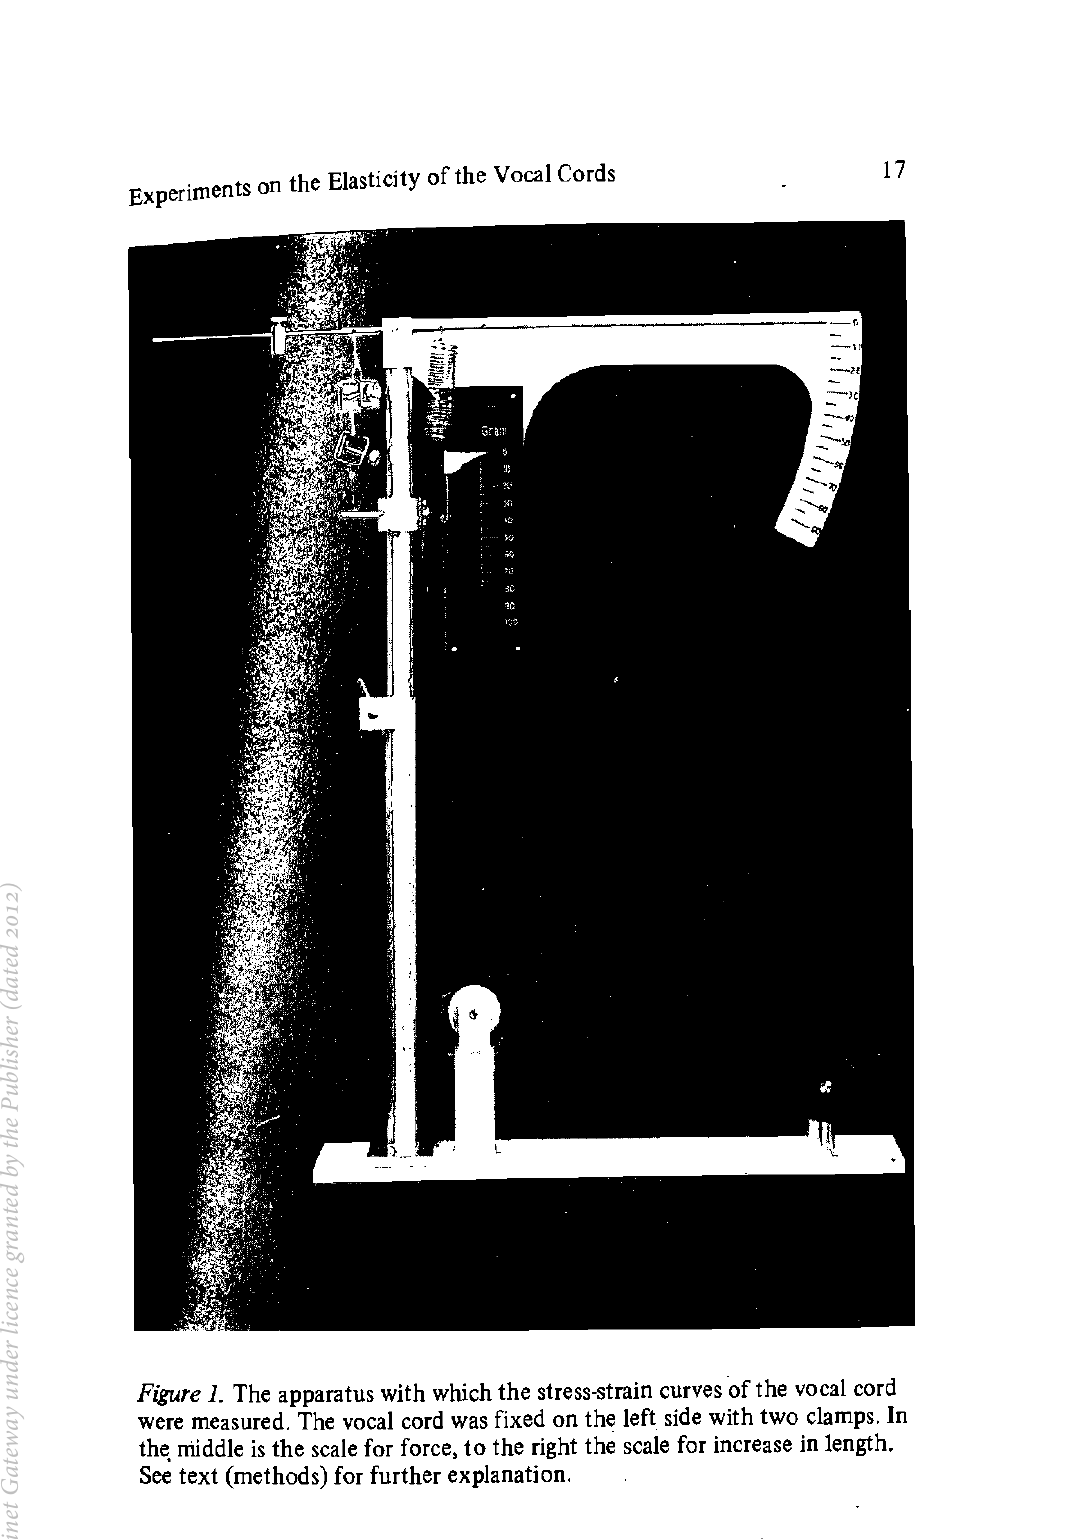
Figure 1. The apparatus with which the stress-strain curves of the vocal cord were measured. The vocal cord was fixed on the left side with two clamps. In the middle is the scale for force, to the right the scale for increase in length. See text (methods) for further